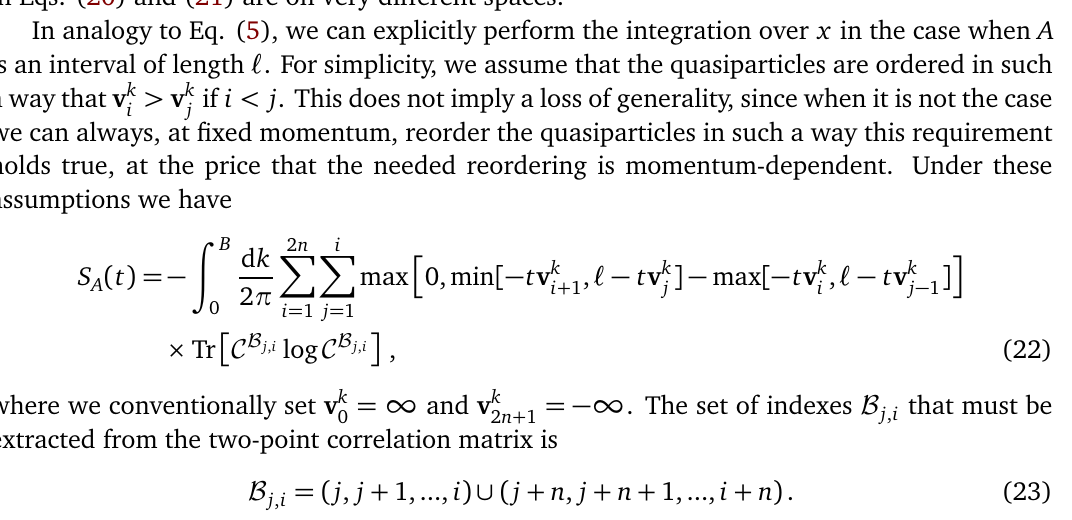
propagates with its own i